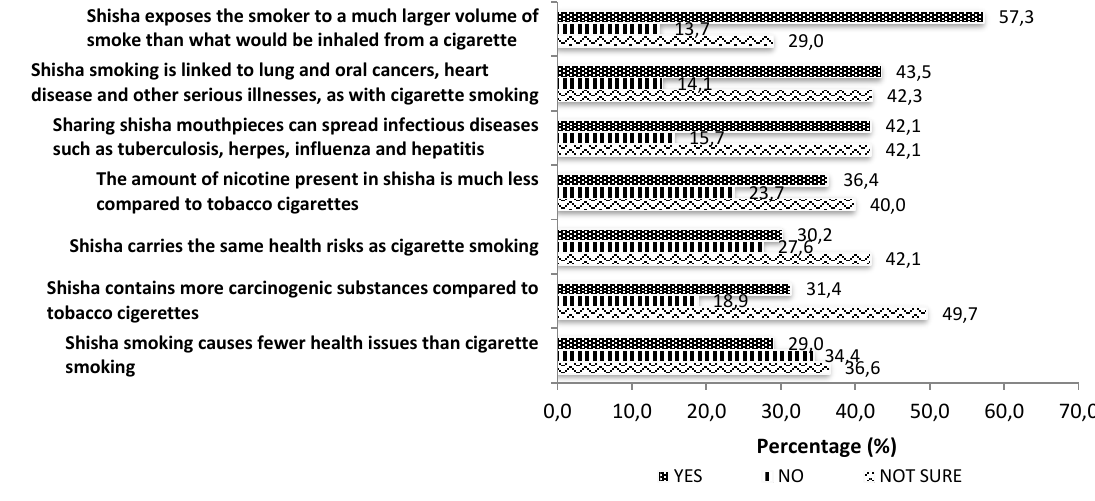
Figure 2. Attitudes towards shisha usage ( N = 503).